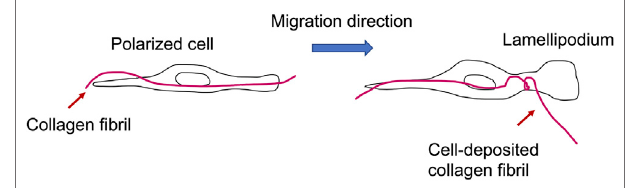
FIGURE 2 | Migrating cells can bend and deposit a collagen fi bril during the formation of lamellipodia in the course of cell migration.